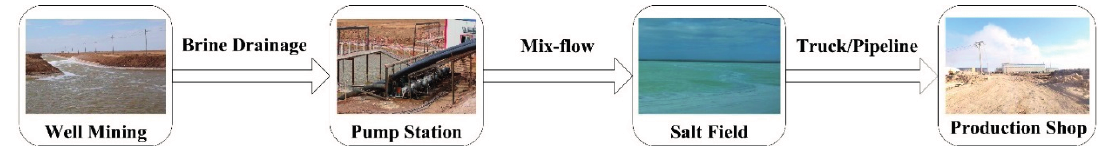
Figure 1. Process and information flow of the brine mining.